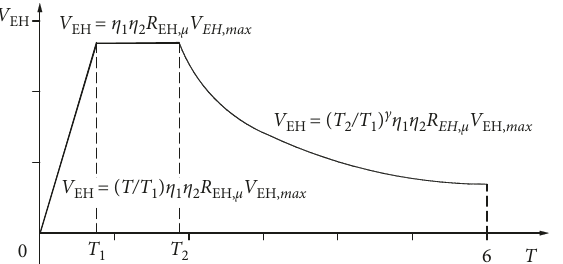
Figure 1: Three-segment model of equivalent velocity spectra of accumulated hysteretic